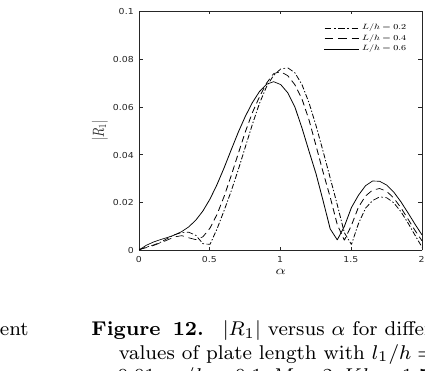
Figure 12. | R 1 | versus α for different values of plate length with l 1 /h = 0 . 01 ,c 0 /h = 0 . 1 ,M = 2 ,Kh = 1 .